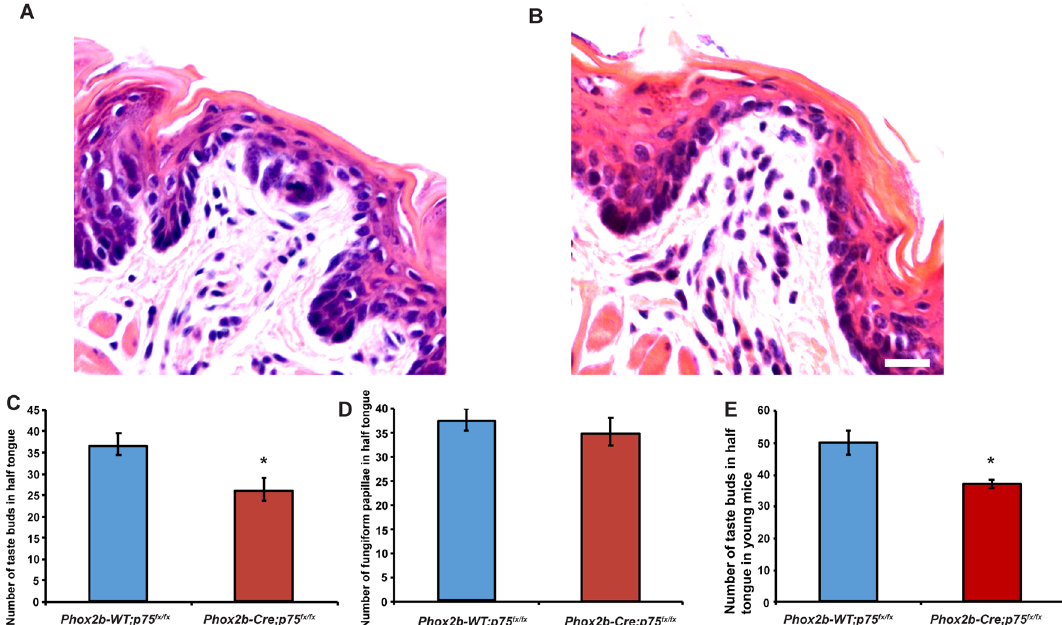
Figure 6. Neural deletion of p75 results in a moderate loss of fungiform taste buds. The tongues from 9–12-month-old Phox2b-Cre; p75 fx/fx and Phox2b-WT; p75 fx/fx mice were serially sectioned, H&E stained and the number of taste buds within fungiform papillae counted. While the majority of fungiform papillae contained taste buds with normal morphology ( A ), some had abnormal, shrunken taste buds or none at all ( B ). ( C ) Quantification of the number of taste buds revealed a reduction in Phox2b-Cre; p75 fx/fx mice compared to Phox2b-WT; p75 fx/fx mice. ( D ) Numbers of fungiform papillae were unchanged between genotypes. ( E ) The number of taste buds in 2–3-month-old Phox2b-Cre; p75 fx/fx mice was reduced as compared to Phox2b-WT; bar in (B) is 25